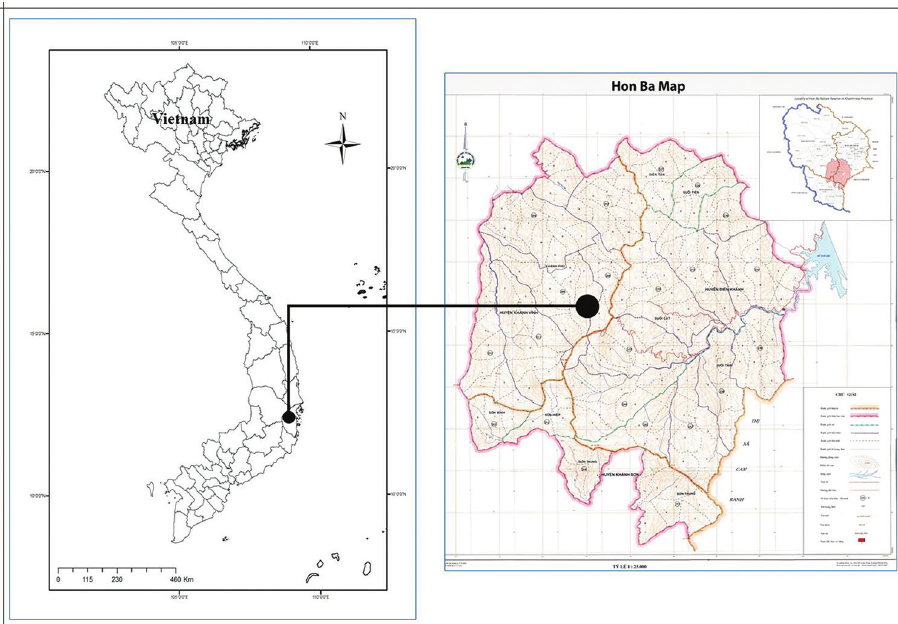
Figure 1. Type locality of Tacca khanhhoaensis V.S. Dang &